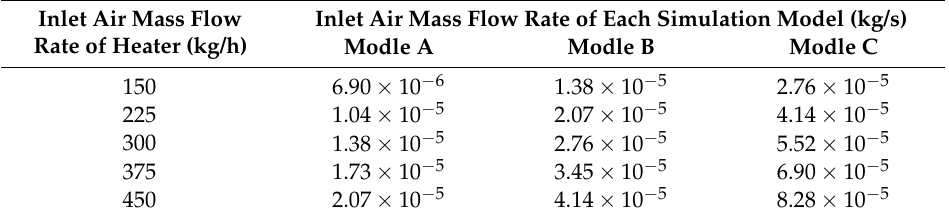
Table 5. Air mass flow conversion for heating performance according to each model.